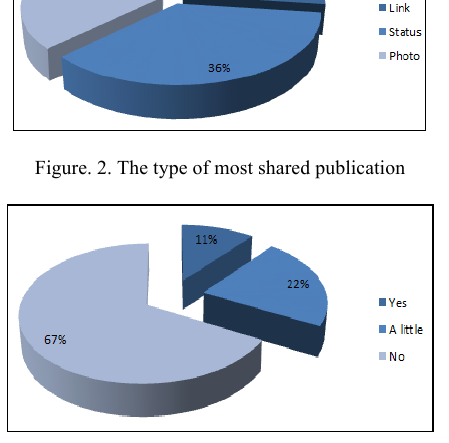
Figure. 3. Satisfaction fans